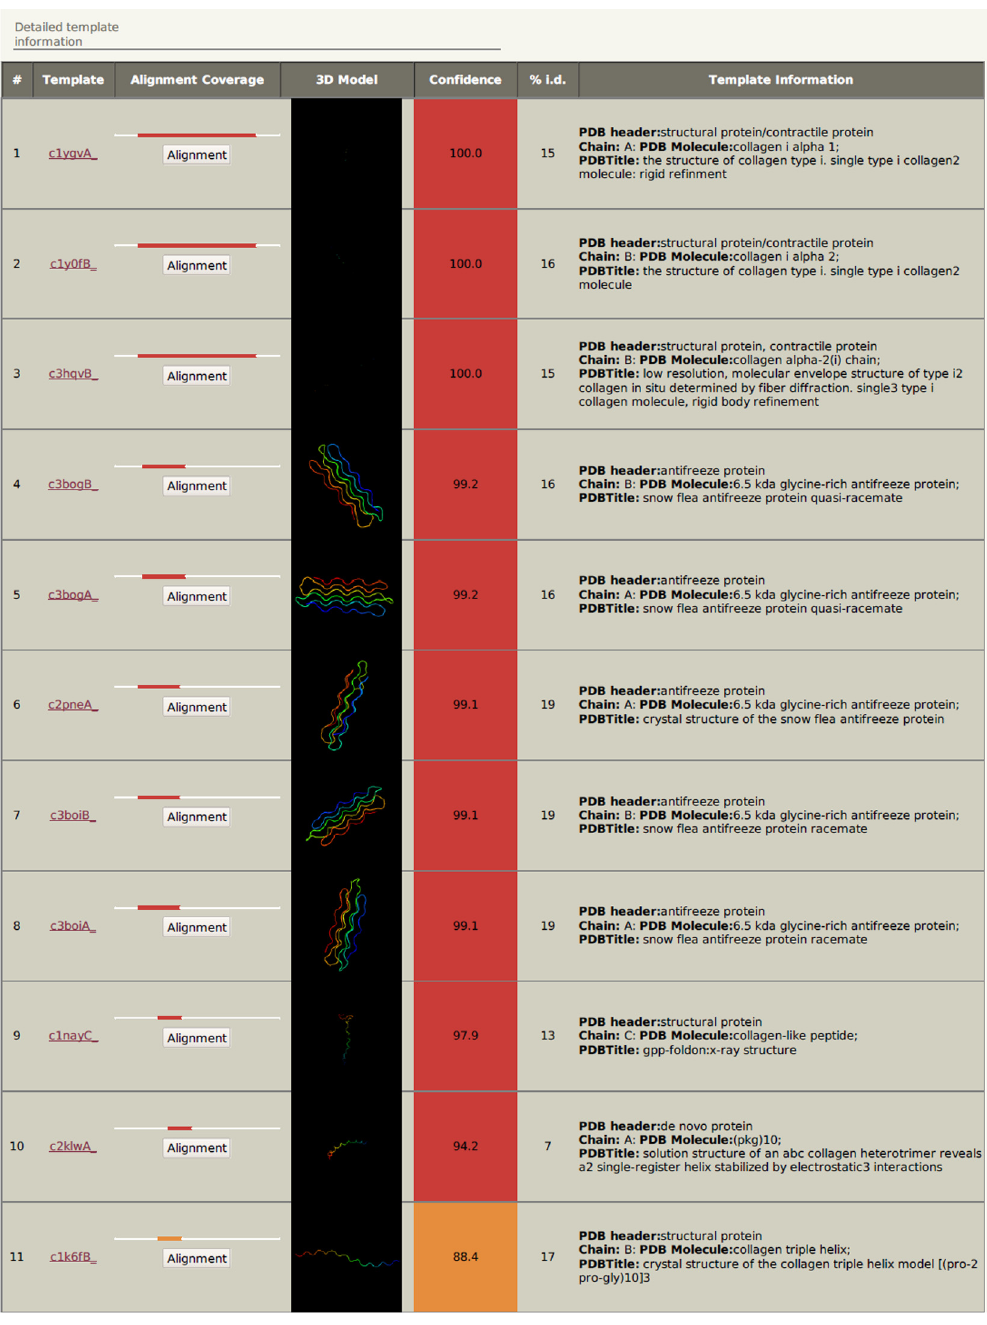
Fig 3. Detailed information about template in the secondary structure